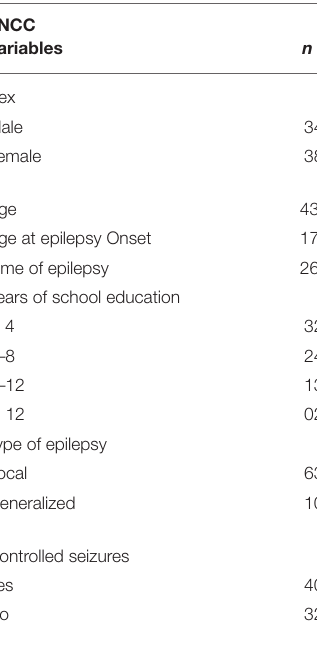
TABLE 1 | Demographic variables of all 731 patients.